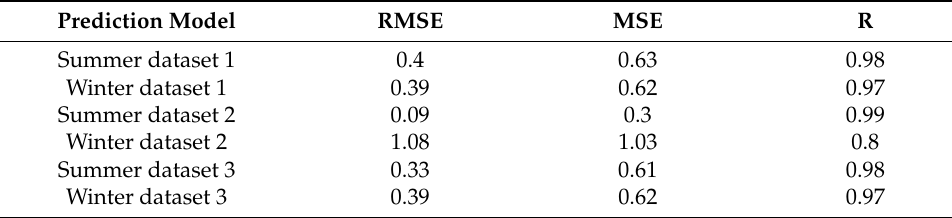
Table 7. Error of each prediction model.